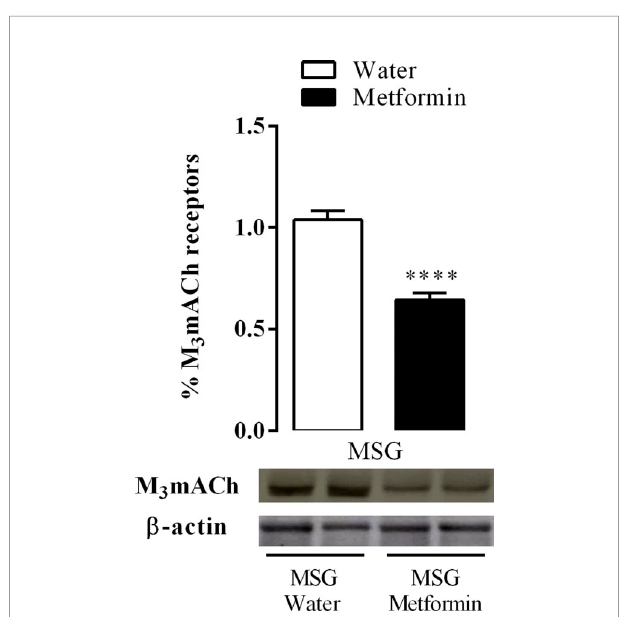
FIGURE 5 | Effect of metformin treatment on M3AChR protein expression in the pancreatic islets from nine rats of three different litters per group for each experimental group. ****p <0.0001 by Student ’ s t-test. Representative western blotting images were originated from the same